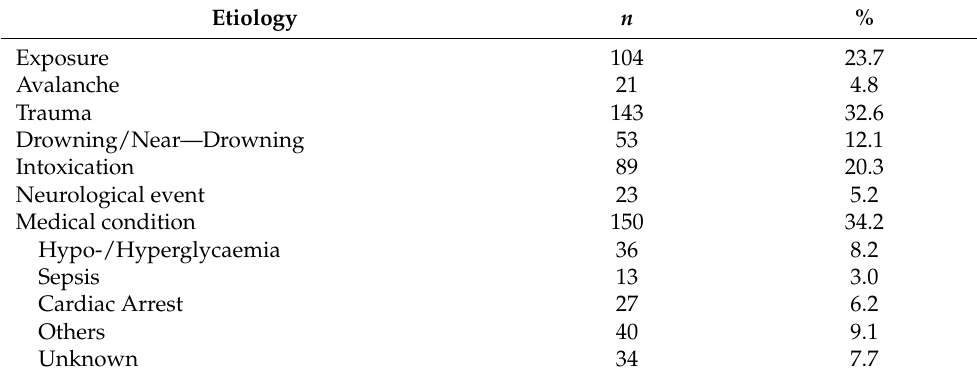
Table 1. Aetiologies (multiple answers allowed).